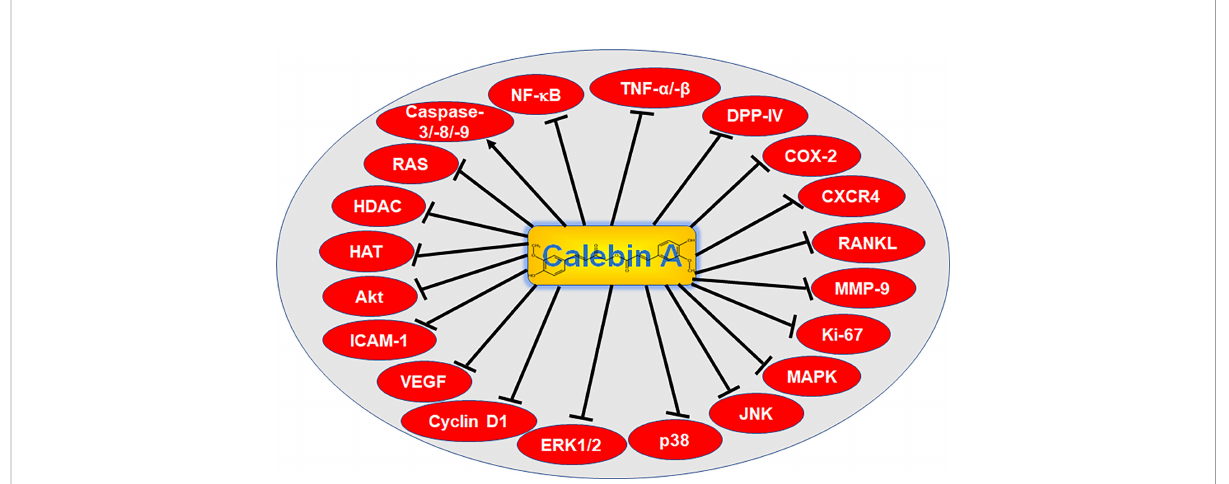
FIGURE 2 Signaling targets of Calebin A. NF- k B, nuclear factor kappa-light-chain-enhancer of activated B-cells; TNF- a /- b , tumor necrosis factor a / b ; DPP-IV, di-peptidyl peptidase IV; COX-2, cyclooxygenase-2; CXCR4, C-X-C chemokine receptor type 4; RANKL, receptor activator of NF- k B ligand; MMP-9, matrix metalloproteinase-9; Ki-67, protein Ki-67; MAPK, mitogen-activated protein kinase; JNK, c-Jun N-terminal kinase; p38, protein kinase of 38 kDa; ERK 1/2, extracellular signal-regulated kinase; VEGF, vascular endothelial growth factor; ICAM-1, intercellular adhesion molecule-1; Akt, serine-threonine protein kinase B; HAT, histone acetyltransferase; HDAC, histone deacetylase; RAS, rat